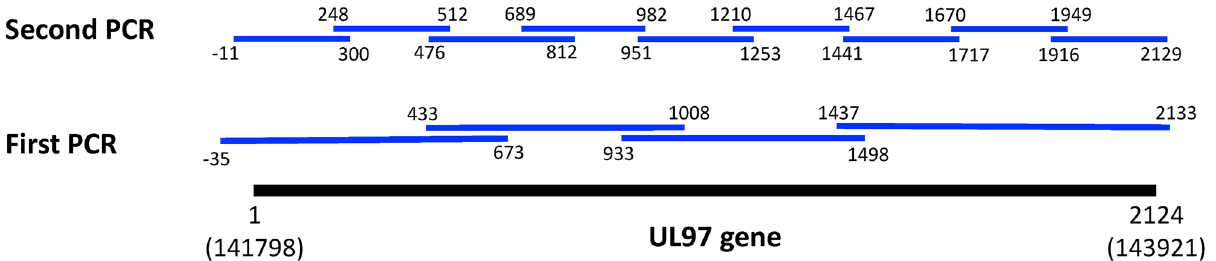
Figure 1. Diagram of nested PCR primer sites for UL97 gene analysis to determine GCV resistance mutation. The full length of UL97 gene (2123 bp) is presented at the bottom. The initial nested PCR primer sites are represented in the lower row. The second PCR primer sites for DNA sequencing are represented in the upper